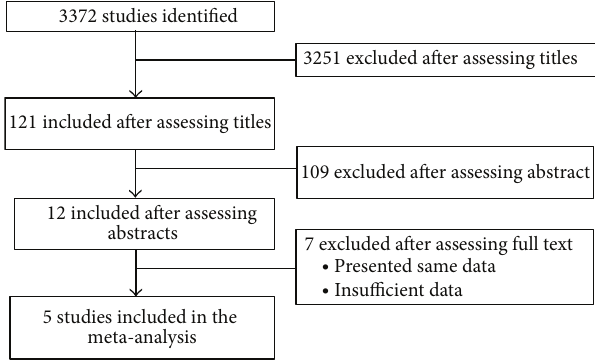
Figure 1: Flowchart for study